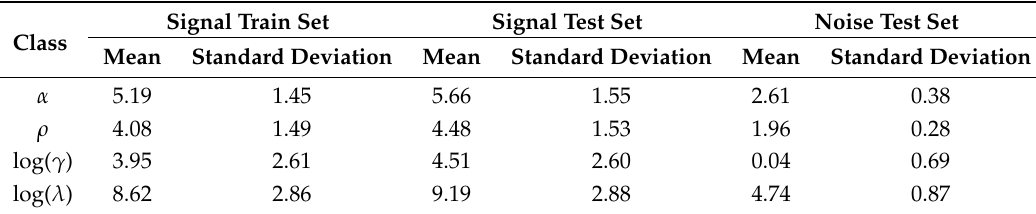
Table 1. Statistical distribution of each waveform feature.